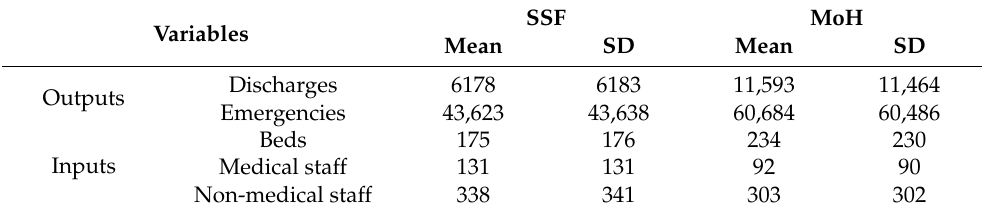
Table 3. Main descriptive statistics for different financial